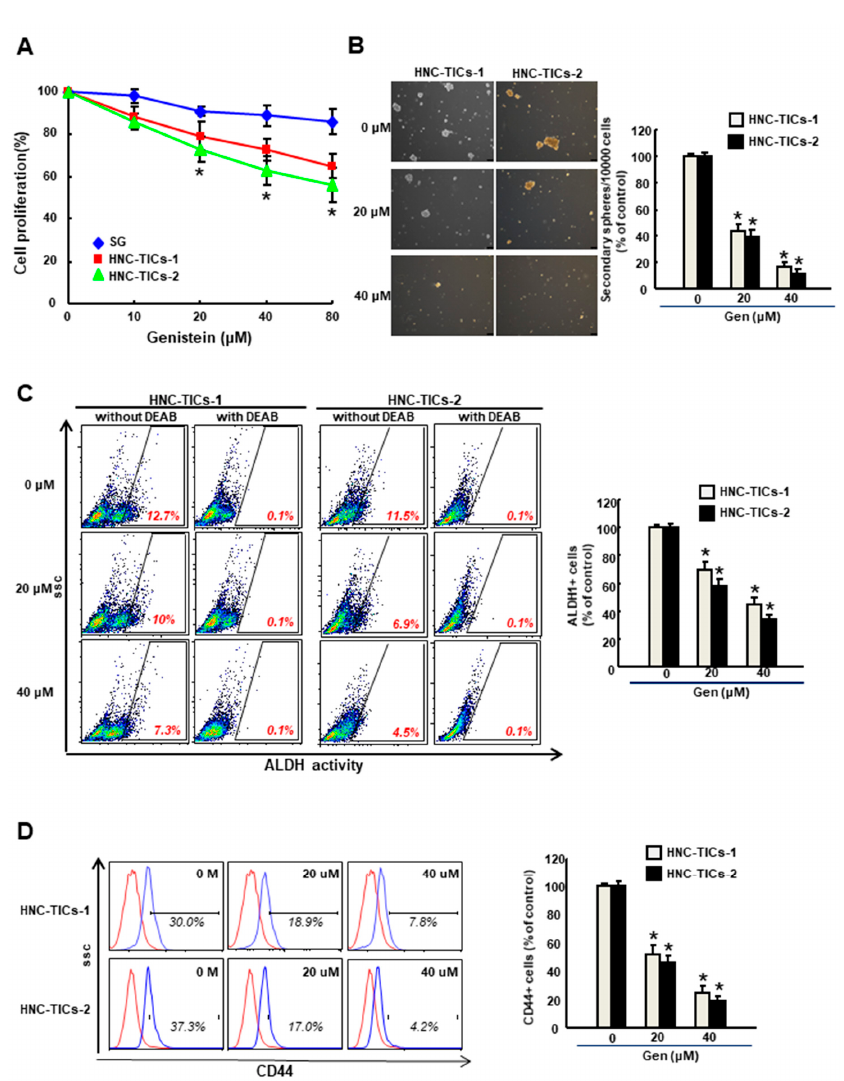
Figure 1. ( A ) Cell proliferation of normal human gingival epithelioid S-G (SG) cells and two lines of patient-derived HNC-TICs (tumor-initiating cells of head and neck cancers) in response to various concentrations of genistein (Gen) using MTT assay; ( B ) Percentage of HNC-TICs formed secondary spheres. Original magnification: 100 × ; scale bar: 100 µ m; the proportion of ( C ) aldehyde dehydrogenase 1 (ALDH1)-expressing and ( D ) CD44-expressing cells in HNC-TICs following treatment of various concentration of genistein using flow cytometry. N,N-diethylaminobenzaldehyde (DEAB) was used as a selective inhibitor of ALDH1. * p < 0.05 compared to no